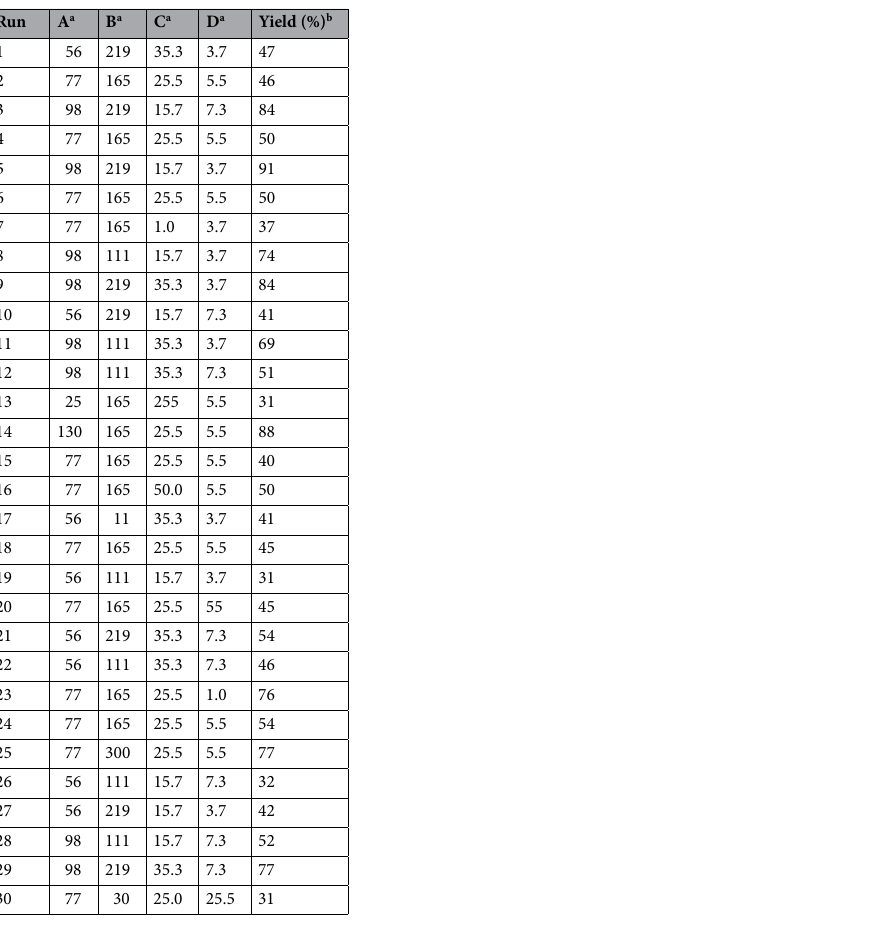
Table 5. RCCCD and experimental data for a 5-level 4-factor response surface methodology. a A, B, C, and D parameters are reaction temperature, reaction time, catalyst loading and molar ratio of alcohol: acid, respectively. b Yields were determined by GC